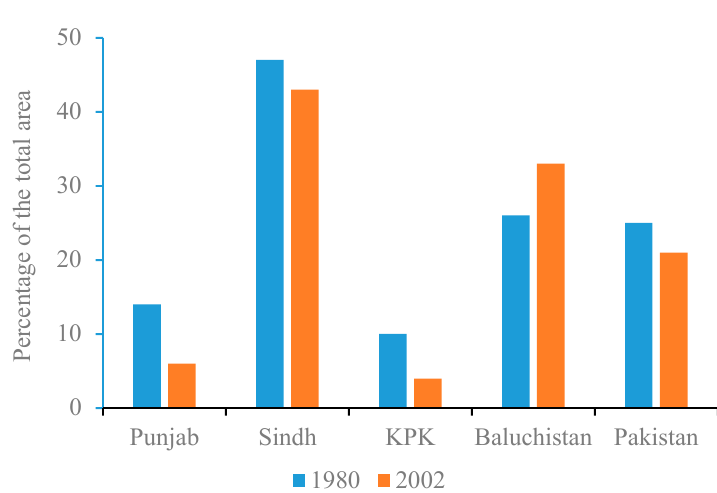
Figure 9. Percentage of the area affected by soil salinity in different provinces of Pakistan (Source: Water and Power Development Authority (WAPDA), 2007).